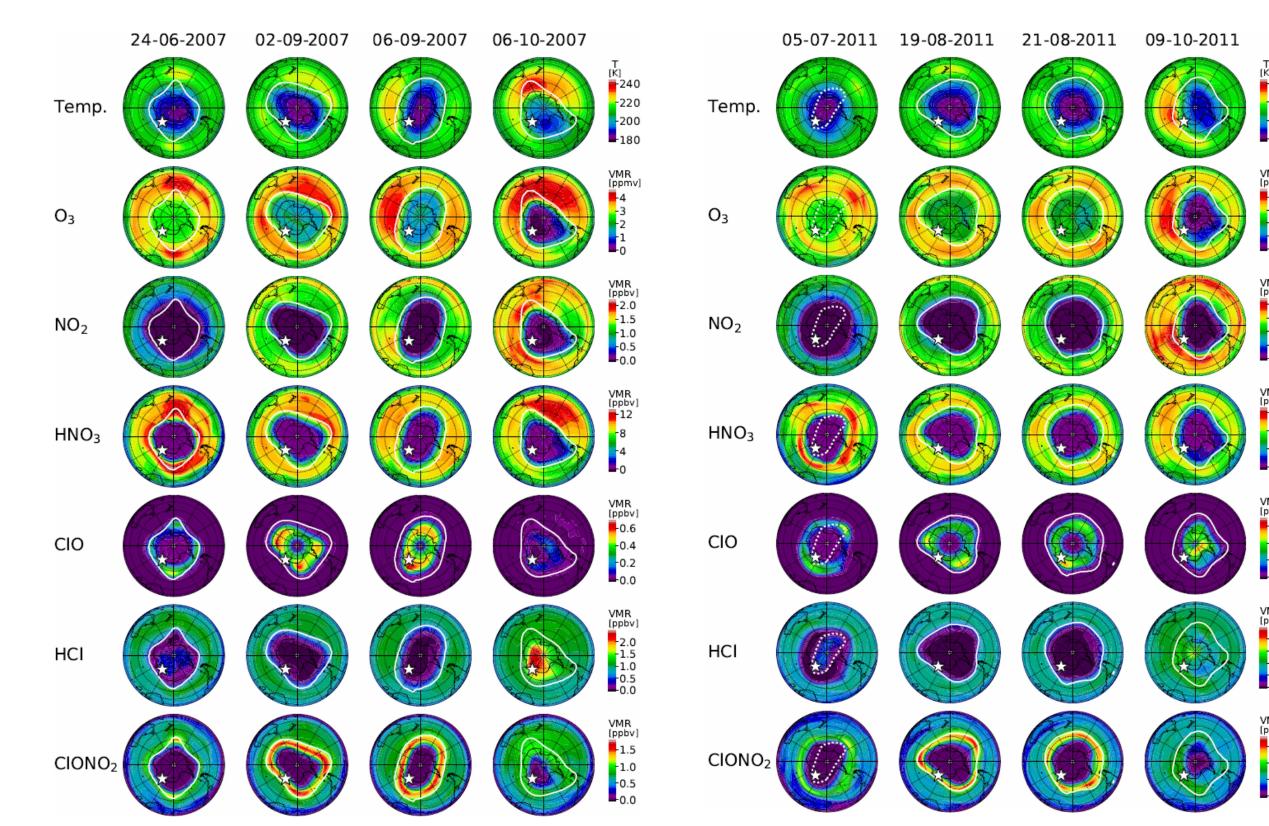
Figure 13. Polar southern hemispheric plots for ERA-Interim tem- perature and simulated mixing ratios of O 3 , NO 2 , HNO 3 , ClO, HCl, and ClONO 2 by a MIROC3.2 chemistry–climate model (CCM) at 50hPa for 24 June (day 175), 2 September (day 245), 6 September (day 249), and 6 October (day 279), 2007. The polar vortex (outer) edge defined as the method described in Appendix B at 450K was plotted by a white outline in each panel. The location of Syowa Sta- tion was shown by a white star in each panel.